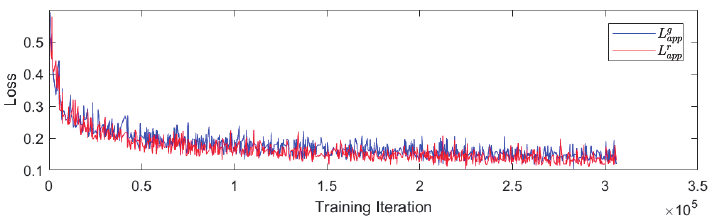
Figure 6. The curve of loss function convergence.